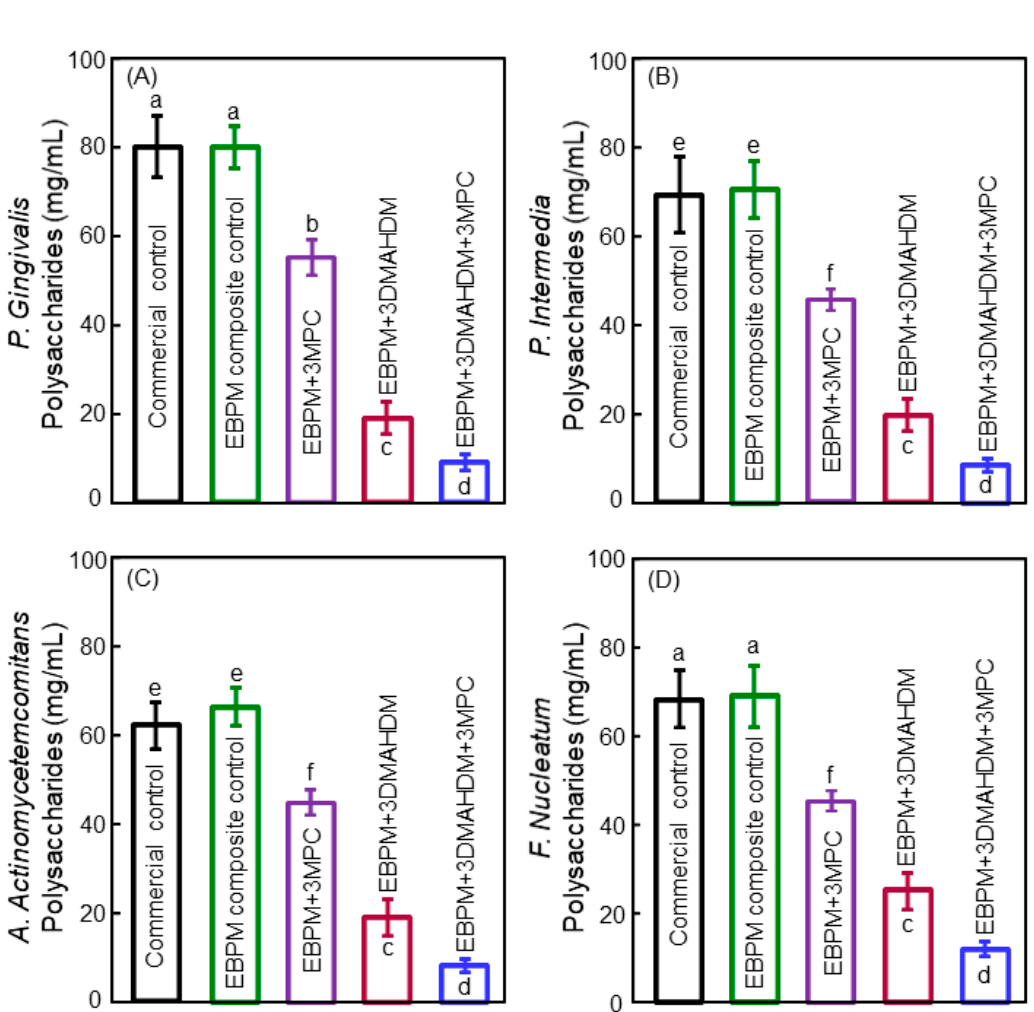
Figure 6. Polysaccharide results in biofilms grown for two days on polymeric composites: ( A )